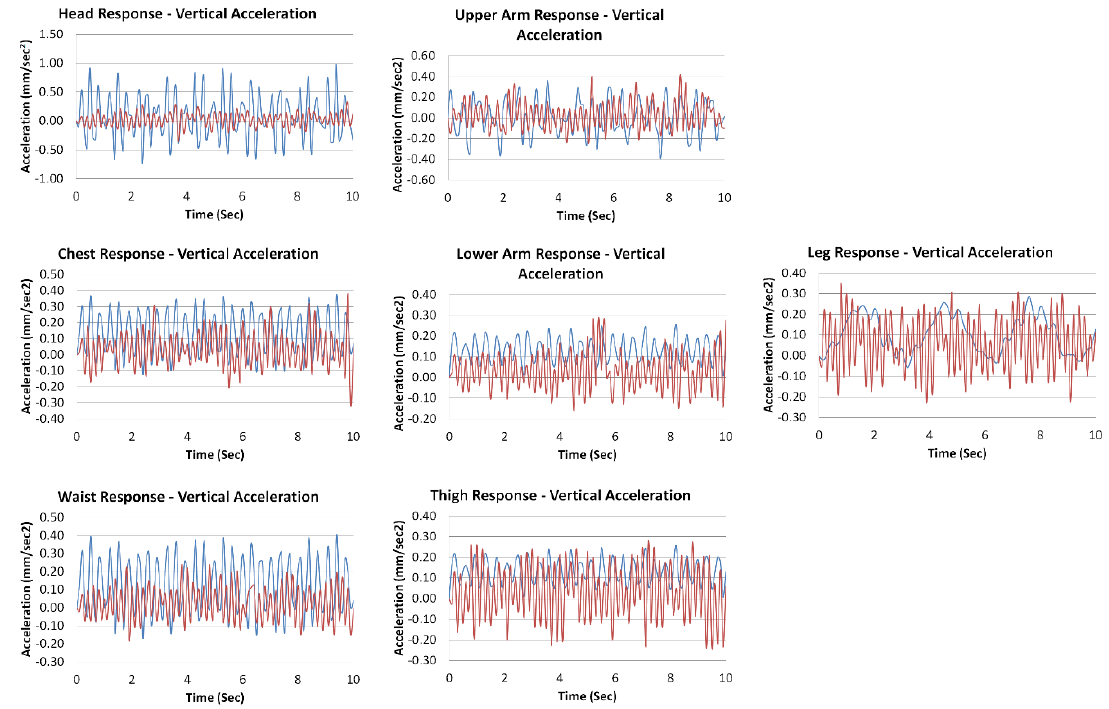
Figure 9. Raw vibration test data for human driver thigh: ( a ) acceleration vs. time, ( b ) power spectrum density vs. frequency.